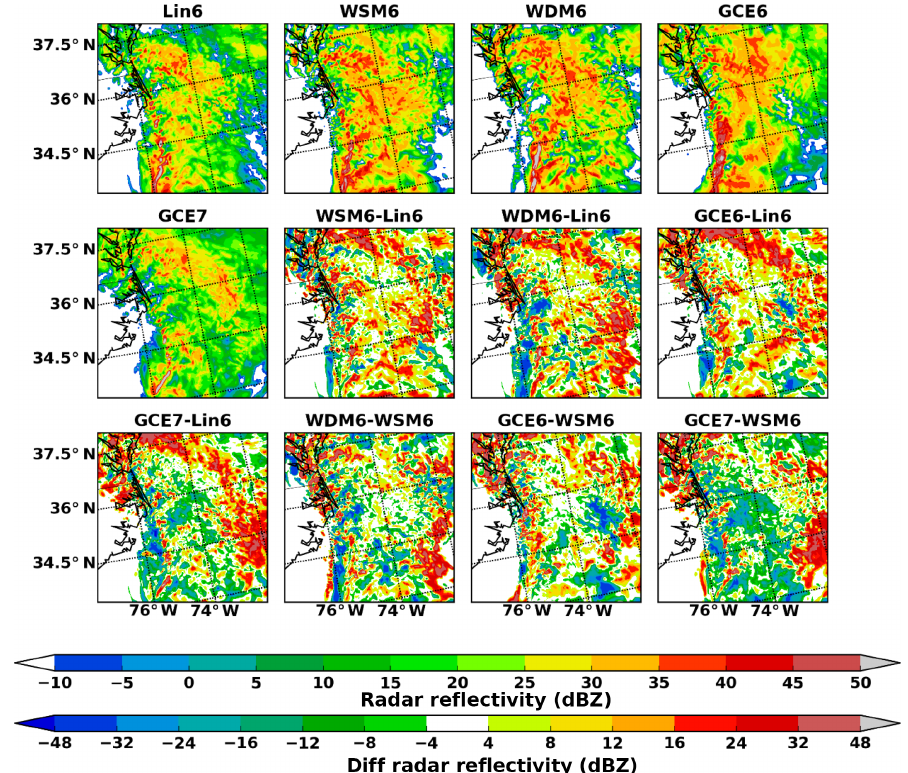
Figure 3. Simulated radar reflectivity (dBZ) at 4000m above mean sea level and their difference at the same time as Fig. 2.